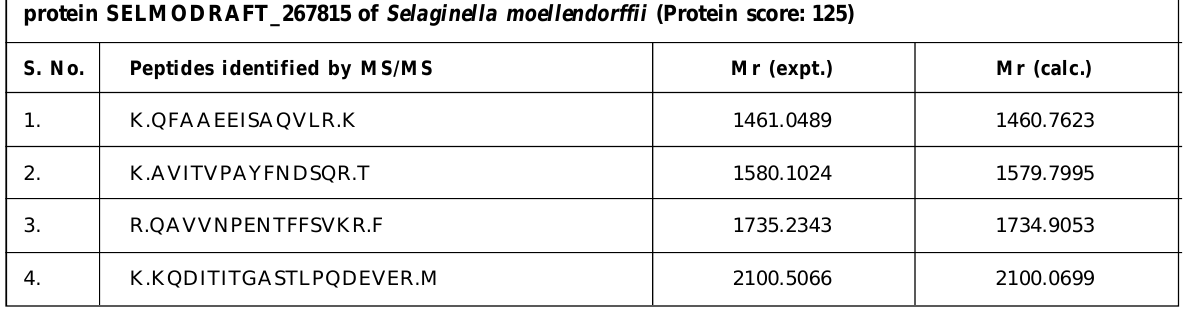
Table 4B: The MALDI TOF mass spectrum sequence of peptides matched with gi|302786294 hypothetical protein SELMODRAFT_267815 of Selaginella moellendorffii (Protein score: 125) S. No.